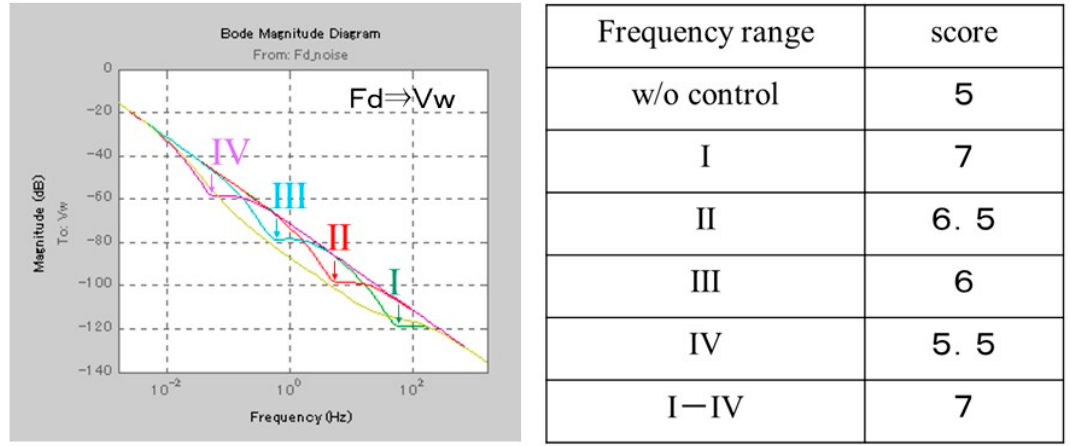
Figure 8. The magnitude of the effect on each control frequency range and the corresponding score of steering feeling.